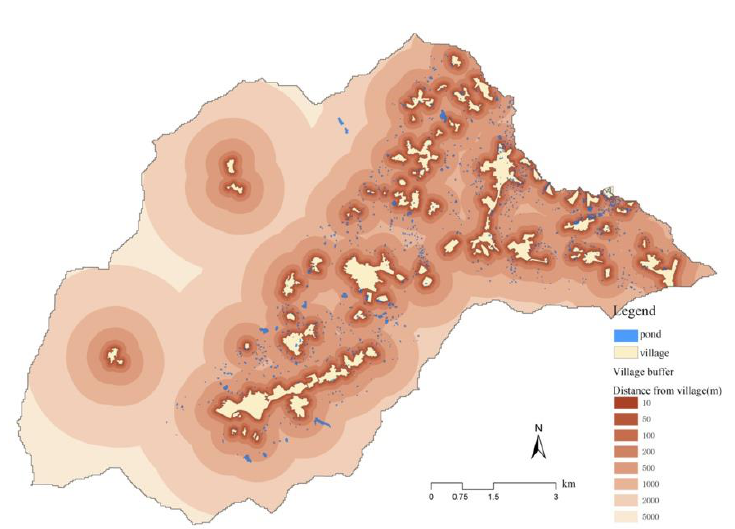
Figure 15. The distance from villages.